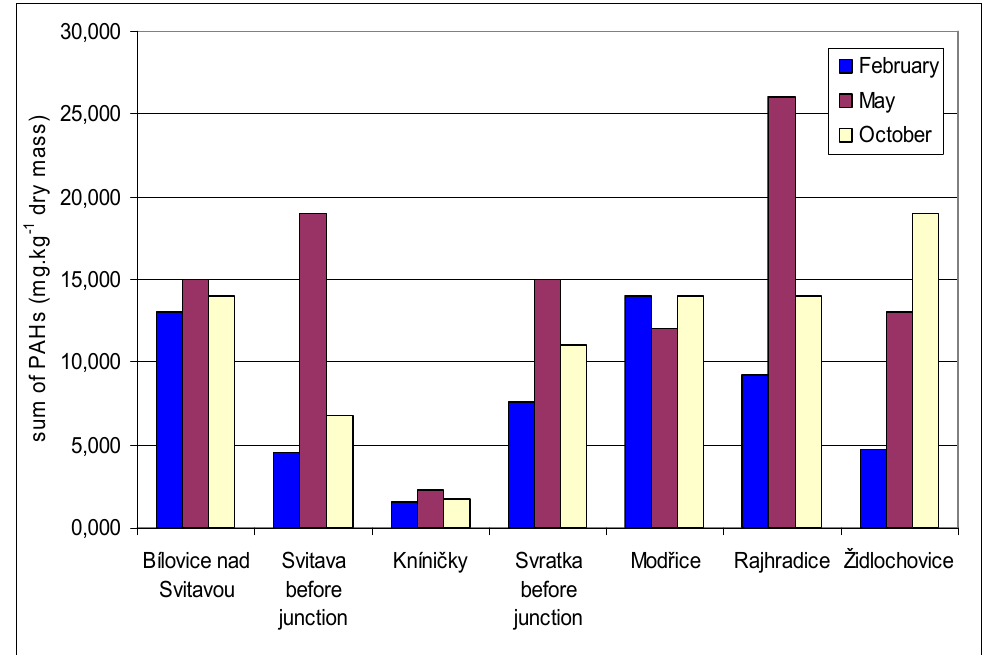
Figure 6. PAH content (in mg·kg -1 dry mass) in sediment samples at monitored